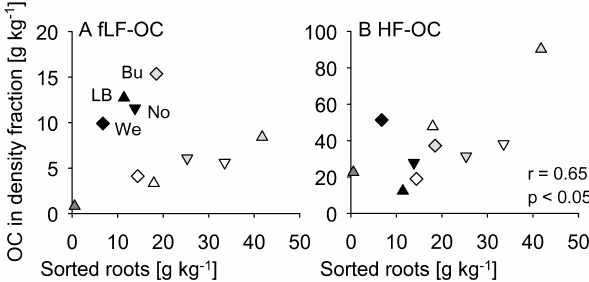
Fig. 6. Correlations between the amounts of sorted out roots in 0– 10cm with OC in the fLF (free light fraction, A ) and OC in the HF (heavy fraction, B ) for the study sites. Cropland sites Gebe- see and Grignon were ploughed before sampling and therefore ex- cluded (Bu: Bugac, LB: Le Bray, We: Wetzstein, No: Norunda, black: coniferous forest, dark grey: croplands, light gray: grass- lands, white: deciduous forests).